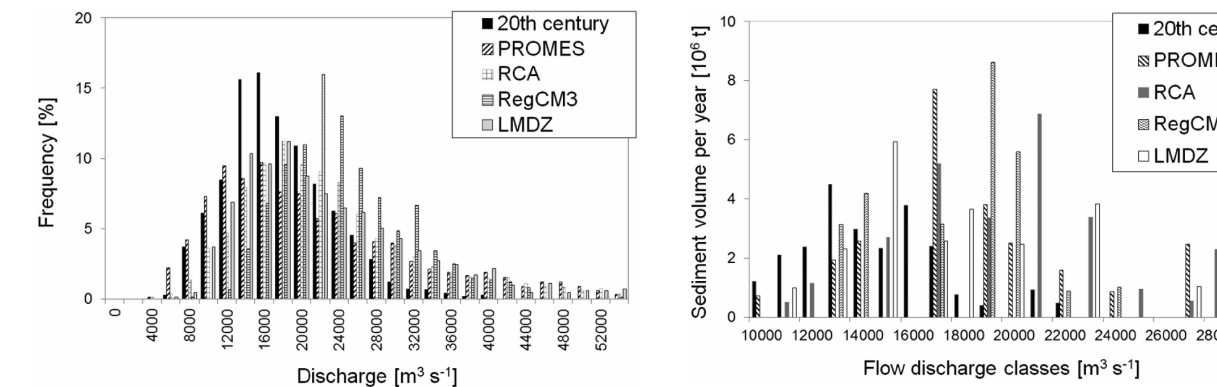
Figure 5. Frequency distributions of monthly flow discharges of ap- plied scenarios for LUFM modelling (20th century and future pre- diction from listed RCMs) at Corrientes.